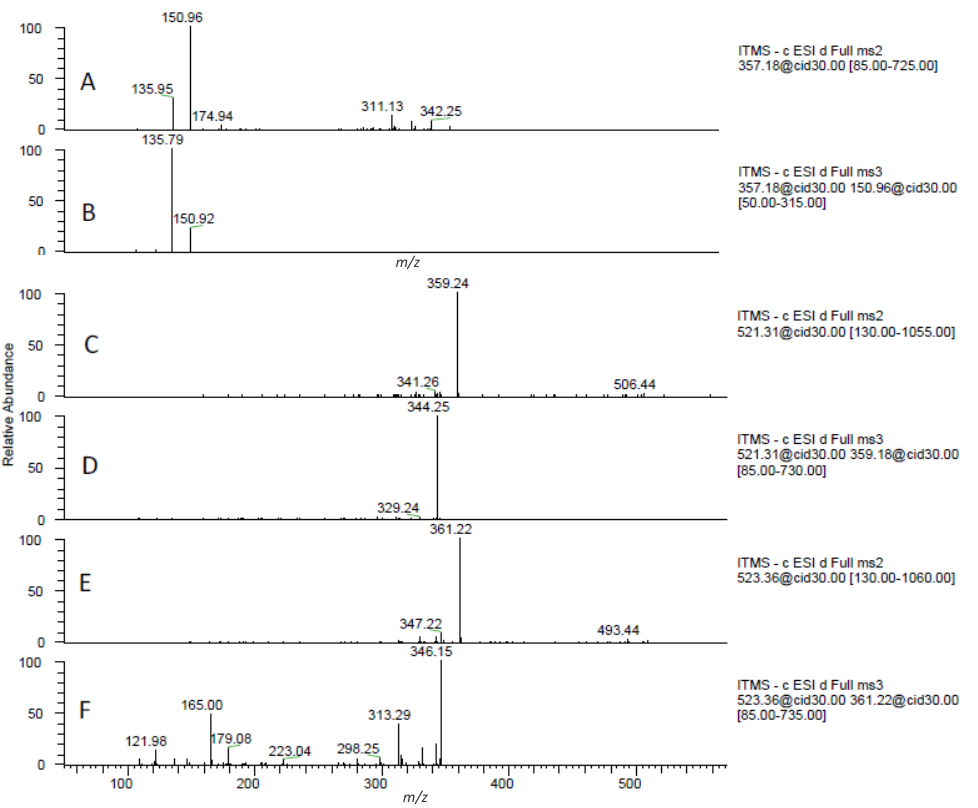
Figure 3. MS 2 and MS 3 fragment ion spectra of pinoresinol ( A and B ), cycolariciresinol hexoside ( C and D ) and secoisolariciresinol hexoside ( E and F ).